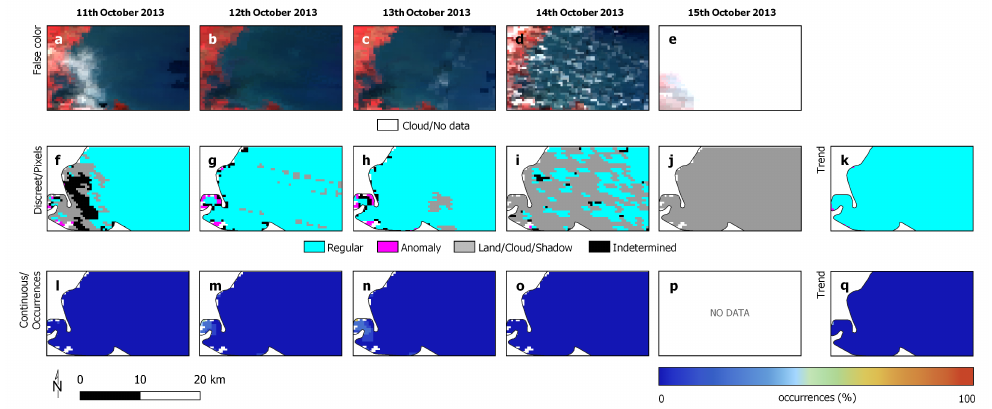
Figure 6. Images ( a – e ) in false-color composition (NIR, red and green bands) for the Lake Erie study area from 11–15 October 2013. Regular, anomaly, land/cloud/shadow and undetermined samples ( f – j ) are identified by cyan, magenta, gray and black polygons, respectively; ( l – p ) show the local anomaly concentration at each instant; ( k , q ) represent the discrete and local anomaly concentration references for the whole forecasting period.